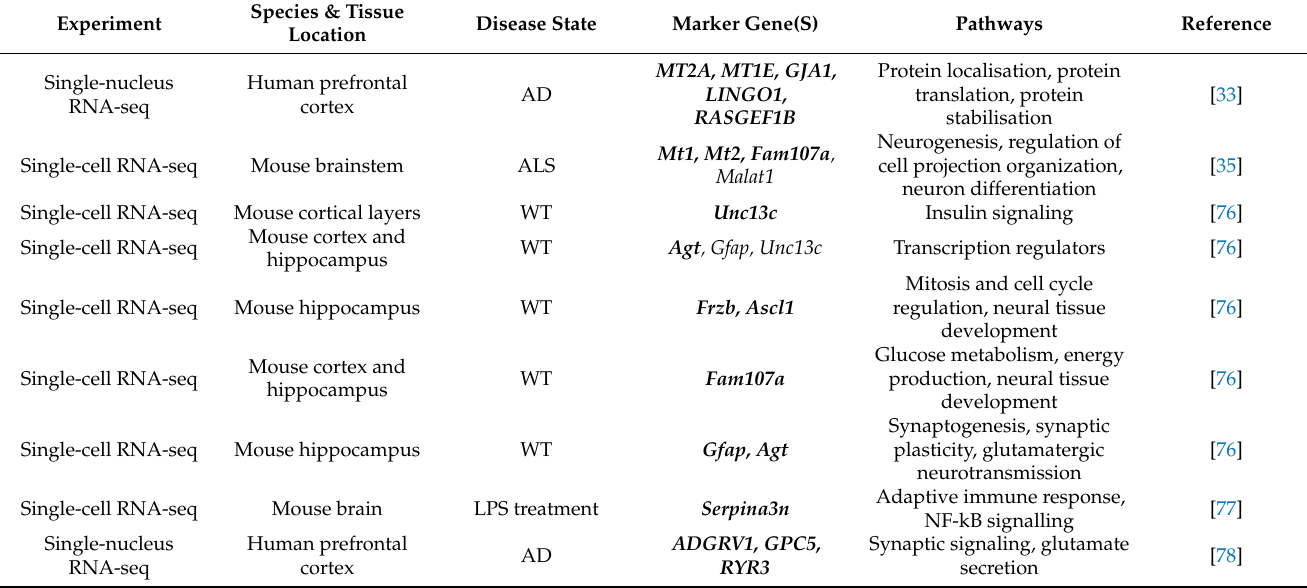
Table 2. Summary of findings from astrocytic RNA sequencing studies. Marker genes in bold are increased. Marker genes that are only italicized are decreased. WT: